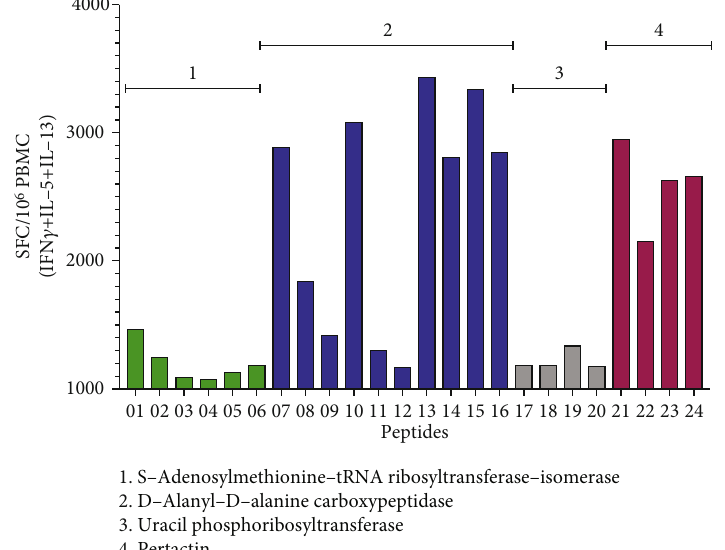
Figure 4: Deconvolution of positive MS reidenti fi es known antigens and identi fi es epitopes from novel antigens. Cytokine production was measured by FluoroSpot after 14 days of in vitro restimulation with BP lysate. The magnitude of responses expressed by spot-forming cells (SFC) is shown for the sum of T cell responses (IFN γ , IL-5, and IL-13) of a representative donor for all individual peptides ( n = 24 ) from a positive mesopool containing the known pertactin antigen. The name of the all the antigens encompassing the group of peptides is shown.